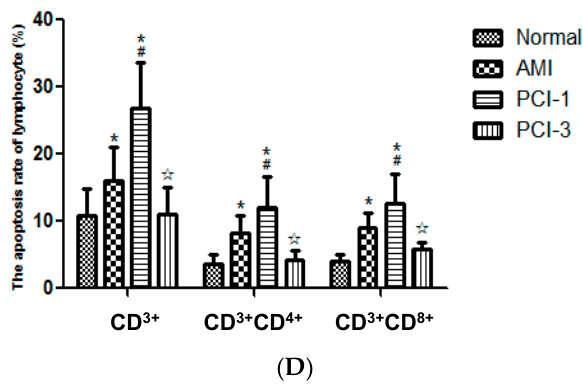
Figure 2. Apoptosis rate of T lymphocytes. FACS results showed that the apoptosis rate of all the T cells of CD 3+ labeled with APC ( A ); CD 3+ CD 4+ labeled with PE ( B ); and CD 3+ CD 8+ labeled with APC-Cy7 ( C ) increased at the onset of AMI and PCI-1, especially the CD 3+ lymphocytes. However, they all returned to normal levels at PCI-3. The apoptosis rate of all these T cells was quantified by densitometry ( n = 20) ( D ). * p < 0.05 vs. Normal group; # p < 0.05 vs. AMI group; ☆ p < 0.05 vs. PCI-1 group.